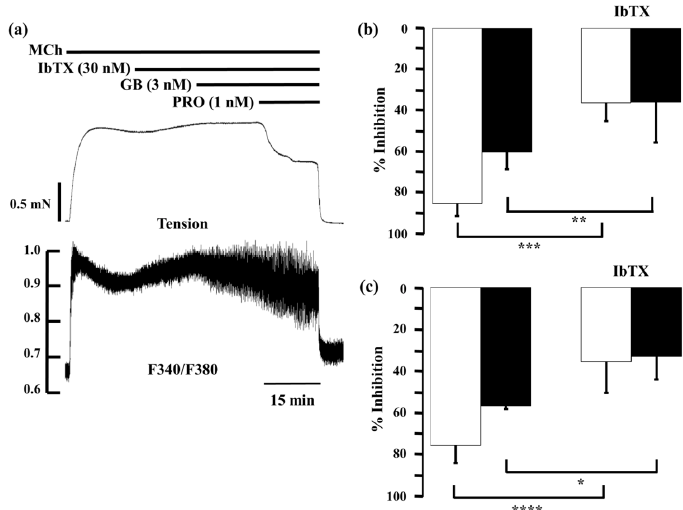
Figure 9. Involvement of large-conductance Ca 2+ -activated K + channel in synergy between β 2 -adrenoceptor agonists and muscarinic receptor antagonists. ( a ) Typical record of tension ( upper side ) and F340/F380 ( lower side ) showing the inhibitory effect of a combination of procaterol (1 nM) and glycopyrronium (3 nM) in the presence of iberiotoxin (30 nM) on MCh (1 μ M)-induced contraction; ( b ) Percent inhibition of tension (white column) and F340/F380 (black column) with combination of procaterol (1 nM) and glycopyrronium (3 nM) in the absence ( left ) or presence ( right ) of iberiotoxin (30 nM); ( c ) Percent inhibition of tension (whitecolumn) and F340/F380 (black column) with combination of salbutamol (10 nM) and glycopyrronium (3 nM) in the absence ( left ) or presence ( right ) of iberiotoxin (30 nM). IbTX, iberiotoxin; GB, glycopyrronium bromide; PRO, procaterol; SB, salbutamol; MCh, methacholine. **** p < 0.0001; *** p < 0.001; ** p < 0.01; * p < 0.05.